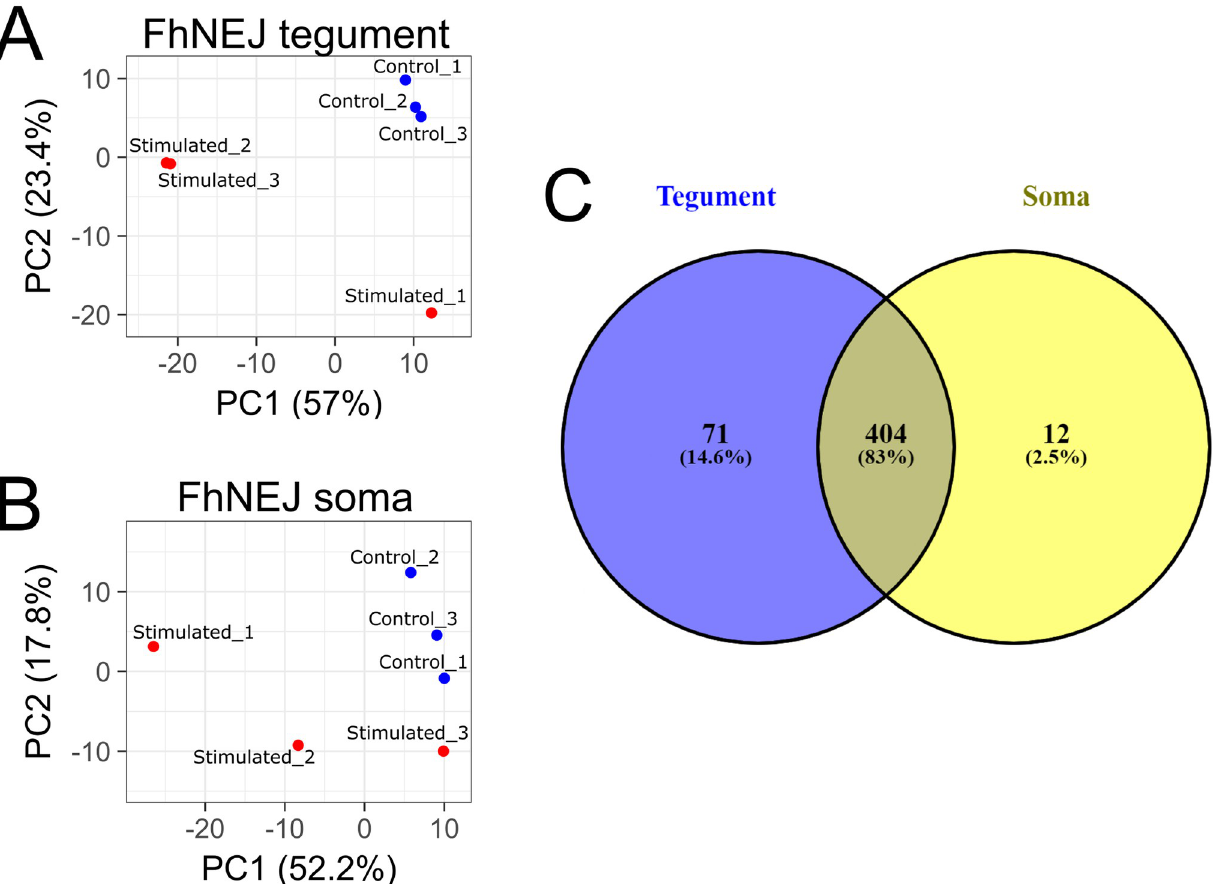
Fig 2. Principal Component Analysis (PCA) of FhNEJ (A) tegument and (B) somatic extracts. Blue dots represent the control replicates (Control_1 to _3) whereas red dots represent the replicates of FhNEJ after migration across the gut wall (Stimulated_1 to _3). The percentage of variance showed by each principal component (PC1 and 2) is indicated in its corresponding axis. (C) Venn’s diagram showing the distribution of quantified